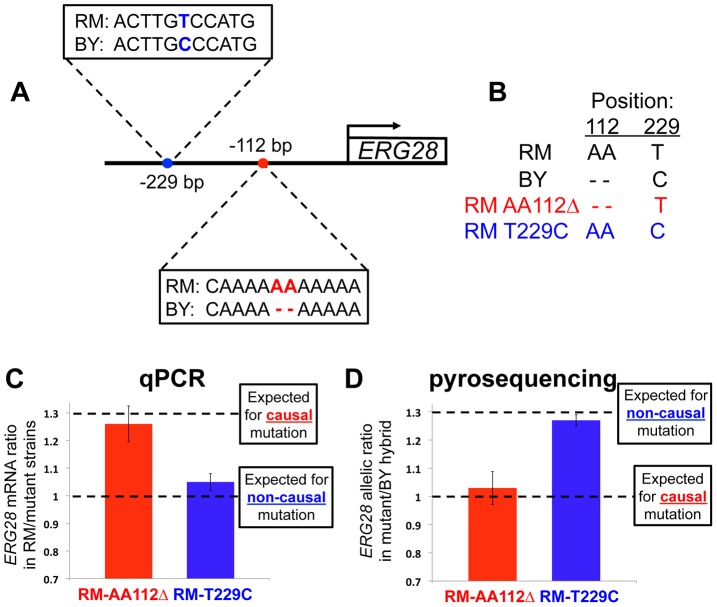
Pinpointing the causal mutation affecting ERG28 cis-regulation.(A) Sequence divergence between RM and BY in the ERG28 promoter region. No other differences exist for 590 bp upstream of the gene, or in the 5′ UTR. (B) Genotypes at the two variable positions for RM, BY, and the two engineered strains. (C) The mRNA levels of ERG28 in each of the two engineered strains compared to wildtype RM, assayed by qPCR. The causal mutation is expected to result in a ∼1.30-fold difference, matching the allelic bias observed in the RM/BY hybrid (Figure 1B), whereas any non-causal mutation will not alter the RM expression level (∼1-fold change). (D) Allelic expression bias in hybrids between each engineered strain and BY, assayed by pyrosequencing. Any non-causal mutation will not alter the 1.30-fold RM/BY allelic bias, whereas the causal mutation is expected to be expressed at the same level as the BY allele (∼1-fold allelic bias).